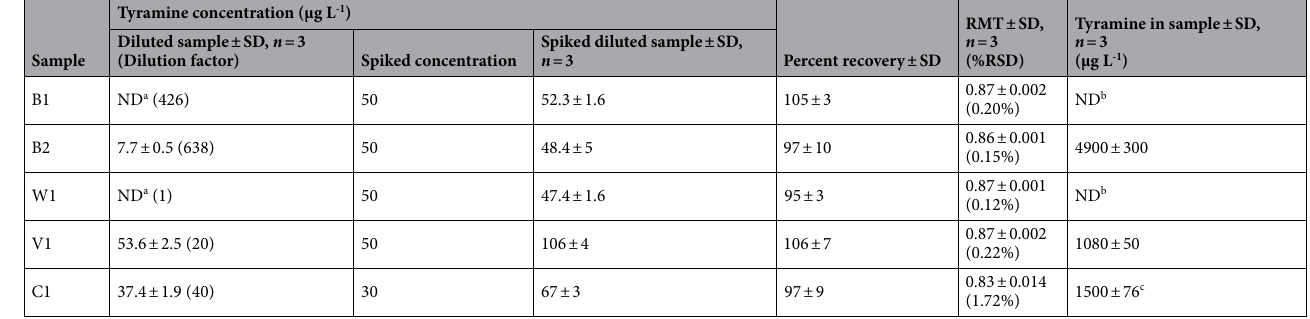
Table 4. Tyramine concentration of diluted samples, recoveries of spiked diluted samples, relative migration times (RMT) and content in samples. Dilution factors for all samples were 426 × , 638 × , 1 × , 20 × and 40 × for B1, B2, W1, V1 and C1, respectively. a ND; Not Detected (< LOD of 4.9 μg L -1 ). b ND; Not Detected (< sample LOD of 2.1 μg L -1 ). c Extracted amount from hard